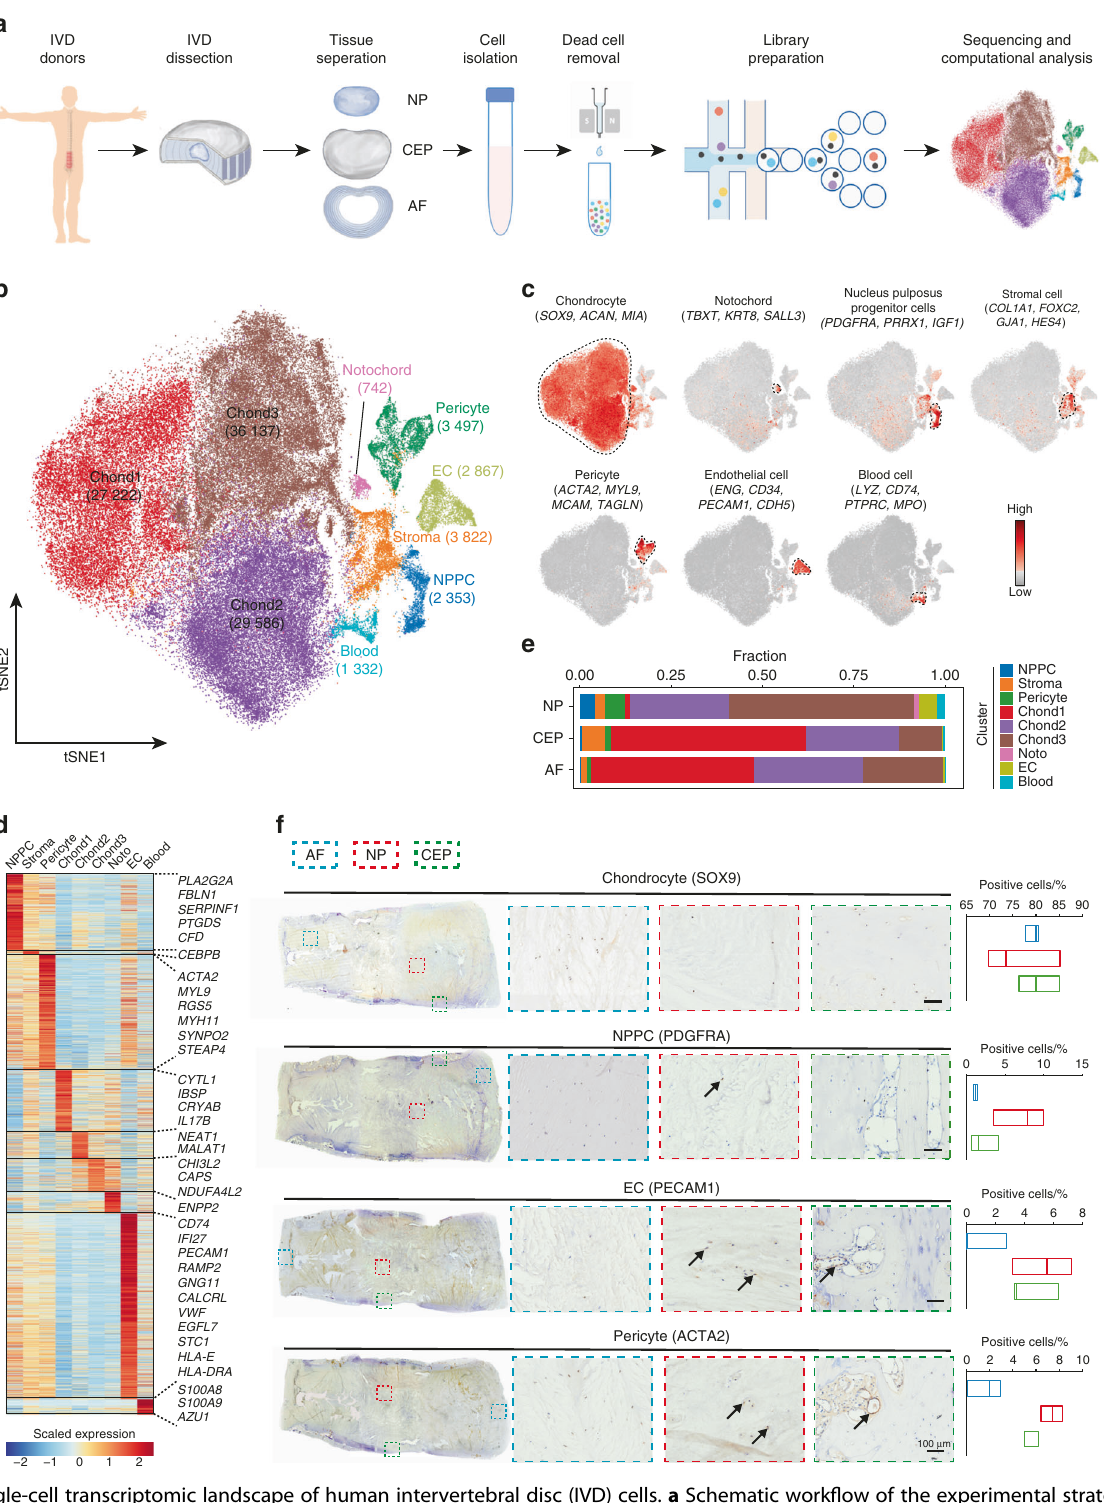
Fig. 1 Single-cell transcriptomic landscape of human intervertebral disc (IVD) cells. a Schematic work fl ow of the experimental strategy. Cells isolated from the NP, AF, and CEP of the human IVD were subjected to droplet-based scRNA-seq. NP nucleus pulposus, CEP cartilage endplate, AF annulus fi brosus, IVD intervertebral disc, scRNA-seq single-cell RNA sequencing. b Distribution of 108 108 cells from human intervertebral disks. Eight cell clusters were visualized by a tSNE plot. Cell numbers for each cluster are indicated in brackets. NPPC nucleus pulposus progenitor cell, EC endothelial cell, Chond chondrocyte, tSNE t-distributed stochastic neighbor embedding. c The average expression of curated feature genes for cell clusters de fi ned in b on the tSNE map. d Heatmap revealing the scaled expression of DEGs for each cell cluster. DEGs differentially expressed genes. e Fraction of cell clusters in the NP, CEP, and AF. f Representative immunohistochemistry staining of signature markers of the indicated cell clusters in the AF, NP, and CEP of healthy human IVD tissues and quanti fi cation of positive cells displayed with a box plot ( n = 3). Scale bar, 100 μ